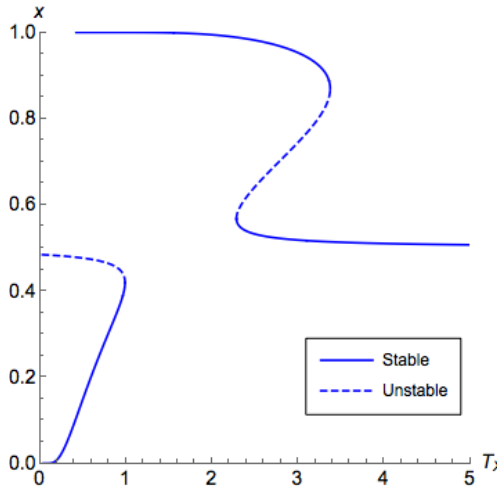
Figure 5. Bifurcation diagram for a coordination game with a Y < b Y and a high T Y . The horizontal axis corresponds to the temperature T x for the first (row) player and the vertical axis corresponds to the probability that the first player chooses the first action in equilibrium. We can find that the principal branch is contained in x > 0.5. In addition, there is a non-stable segment on the principal